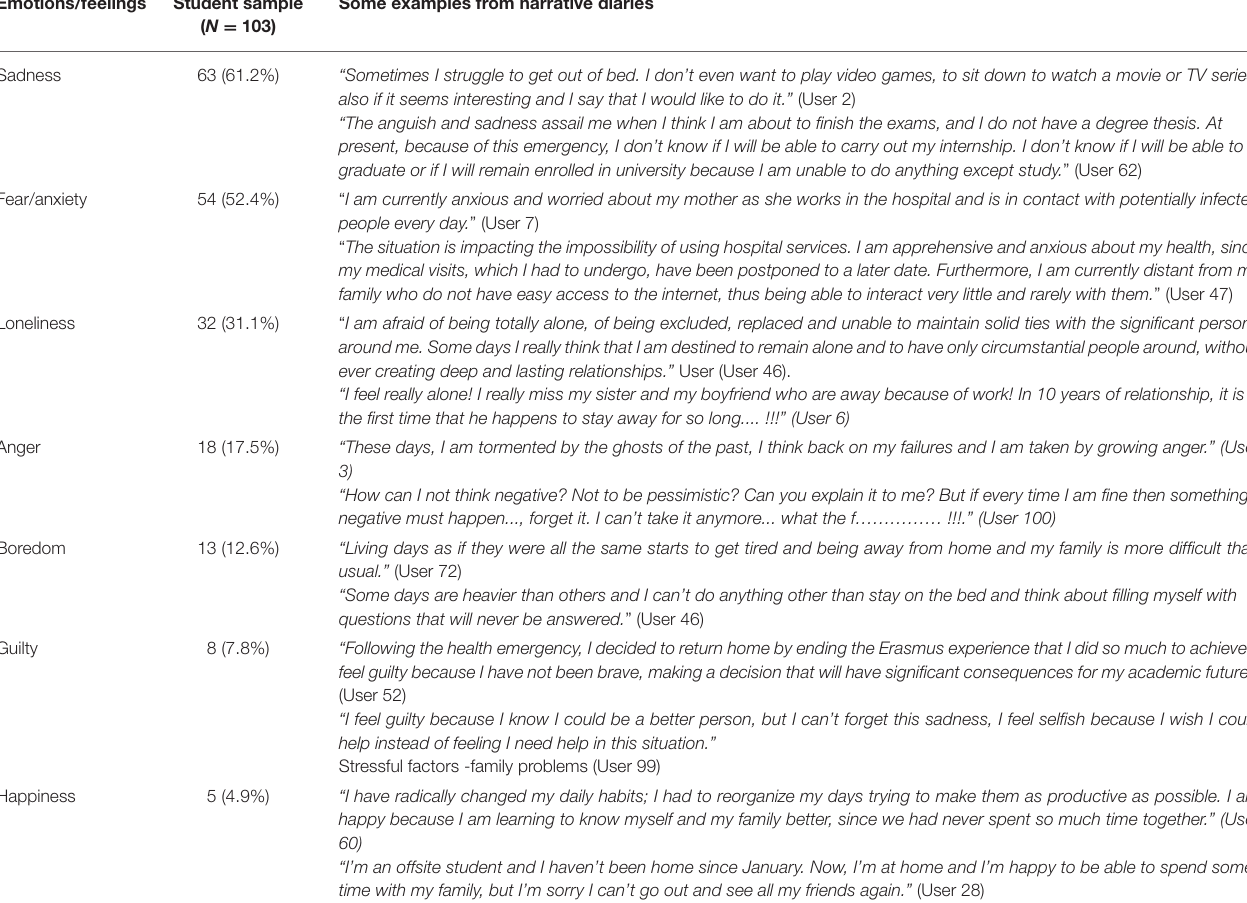
TABLE 3 | Emotions/feelings reported by students in their digital narrative diaries during the lockdown. Emotions/feelings Some examples from narrative diaries